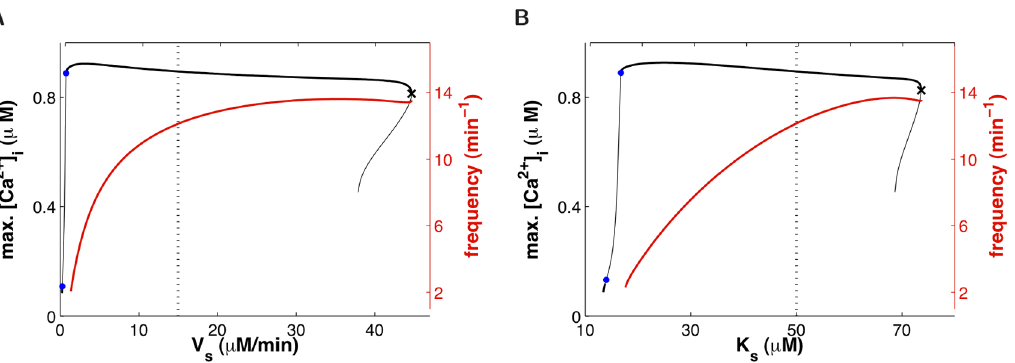
Figure 5. Influence of SOCE on agonist-induced ½ Ca 2 z (cid:2) oscillations. Amplitude (black) and frequency (red) of Ca 2 z oscillations as a function i of (A) SOCE maximum rate, V s , and (B) STIM affinity for SR Ca 2 z , K s . Dotted lines indicate the ‘‘normal’’ parameter values (Table 1, Figs. 3D–F). As in Fig. 4, only the frequency of the large-amplitude stable Ca 2 z oscillations is